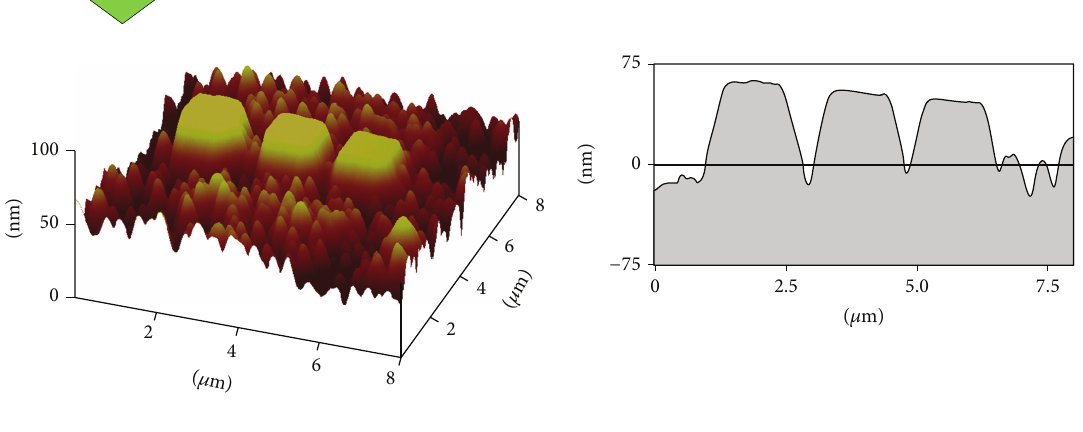
performed three more times. Measured values were different but exhibited the same trend.